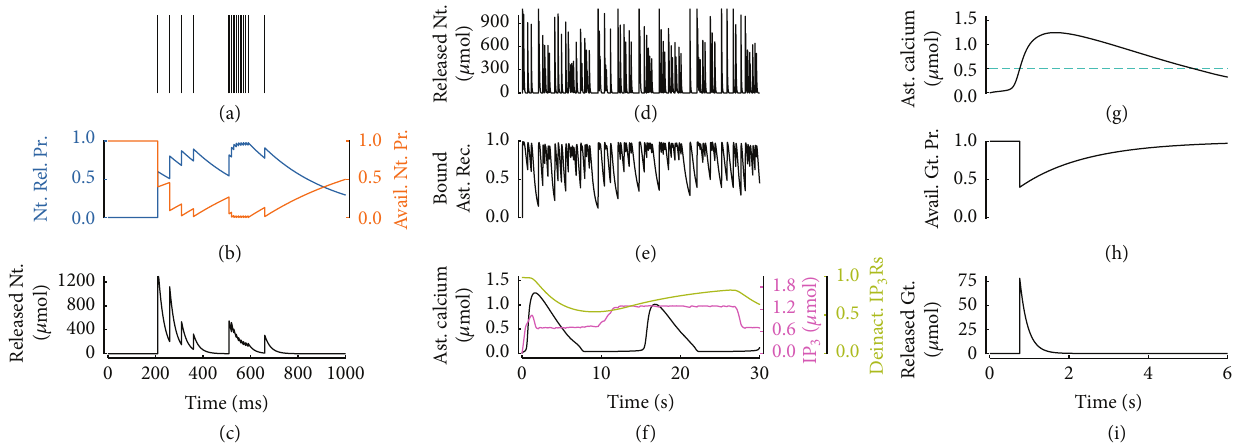
Figure 2: Biophysical modeling of a gliotransmitter-regulated synapse. ((a)–(c)) Model of synaptic release. Incoming presynaptic spikes (a) increase intrasynaptic Ca 2+ levels which directly control the probability of release of available neurotransmitter resources ((b), Nt. Rel. Pr.) and decrease, upon release, the fraction (or probability) of neurotransmitter-containing vesicles available for release (Avail. Nt. Pr.). Each spike results in release of a quantum of neurotransmitter from the synapse ((c), Released Nt.) whose concentration in the perisynaptic space decays exponentially. Synapse parameters: 𝜏 𝑑 = 0.5 s, 𝜏 𝑓 = 0.3 s, and 𝑈 0 = 0.6 . Stimulation by Poisson-distributed APs with an average rate of 5 Hz. ((d)–(f)) Model for astrocyte activation. Synaptically released neurotransmitter in the perisynaptic space (d) binds astrocytic receptors ((e), Bound Ast. Rec.), resulting in IP 3 production which triggers Ca 2+ signaling in the astrocyte (f). This latter also depends on the fraction of deinactivated IP 3 receptors/Ca 2+ channels (Deinact. IP 3 Rs) on the astrocyte ER membrane (see Appendix A.1). ((g)–(i)) Model for gliotransmitter release. The increase of astrocytic Ca 2+ beyond a threshold concentration ((g), cyan dashed line ) results in the release of a quantum of gliotransmitter, which decreases the probability of further release of gliotransmitter ((h), Avail. Gt. Pr.) while transiently increasing extracellular gliotransmitter concentration ((i), Released Gt.). Model parameters as in Table